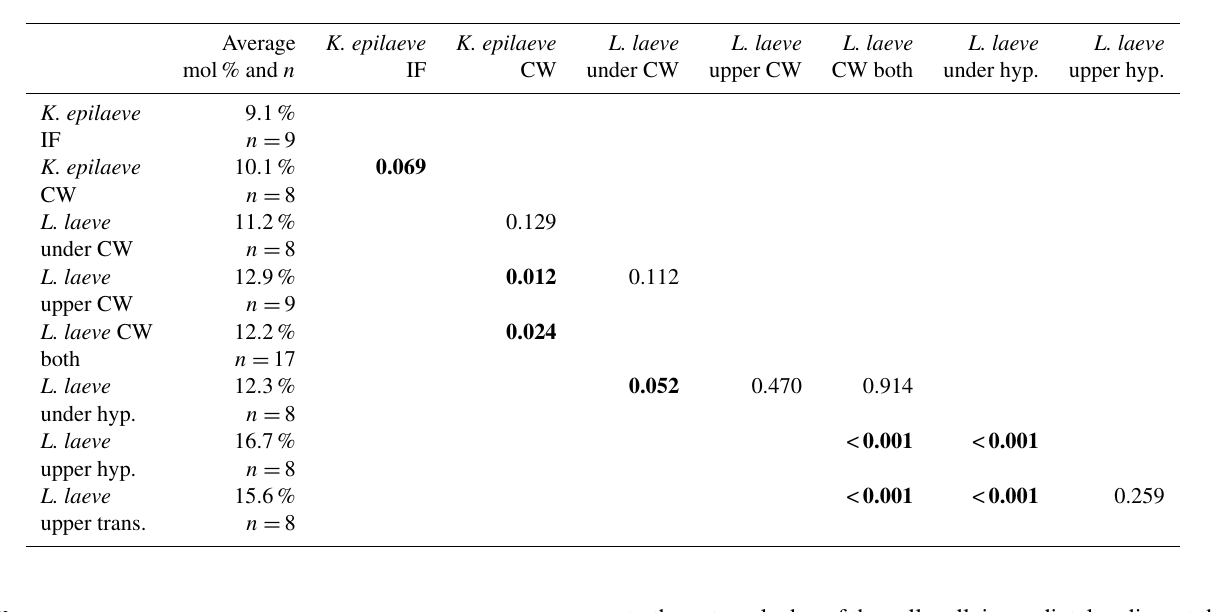
Table 2. T -test p values for 15kV spot EDS.